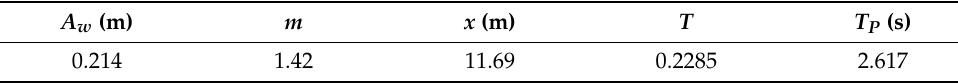
Table 1. Parameters of the wave for the first and second